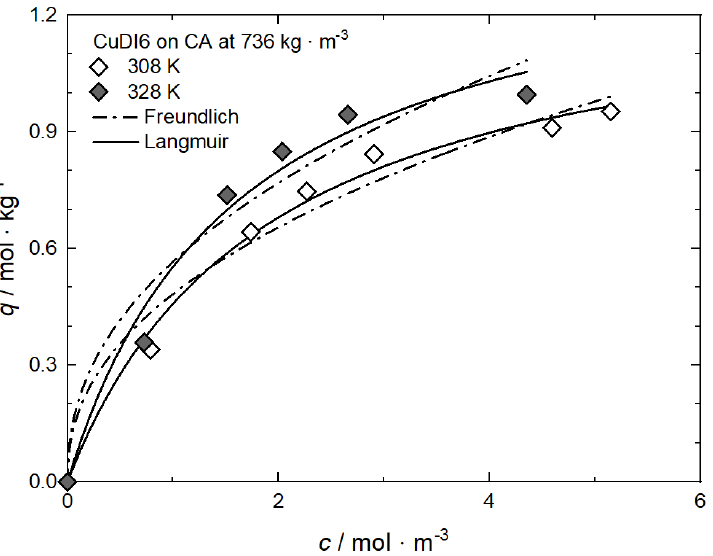
Figure 12. Uptake of CuDI6 on CA at ρ = 736 kg · m − 3 and different temperatures; experimental data taken from [61].